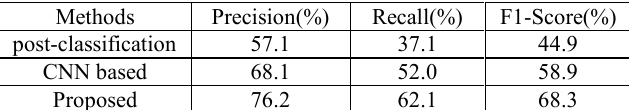
Table 2. The quantitative evaluation matric of CNN based method and the proposed method.